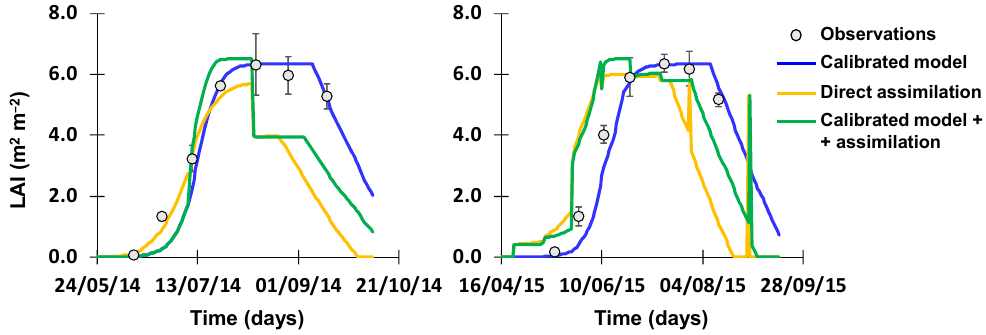
Figure 4. Measured and simulated leaf area index during 2014 ( left ) and 2015 ( right ) crop seasons. Vertical bars correspond to the standard deviation of measured data.